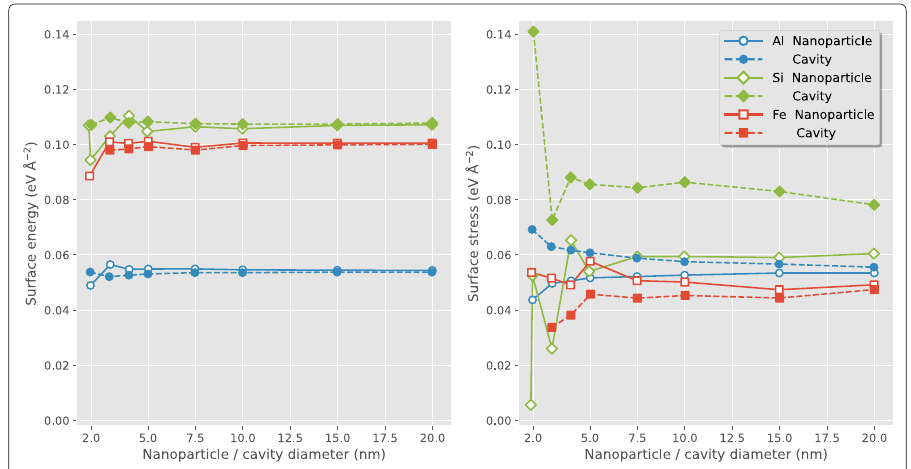
Fig. 3 Surface energy (left) and stress (right) of nanoparticles (open symbols, full lines) and cavities (filled symbols, dashed lines) as a function of their diameter, for aluminum (circles, blue), silicon (diamond, green), and iron (square,